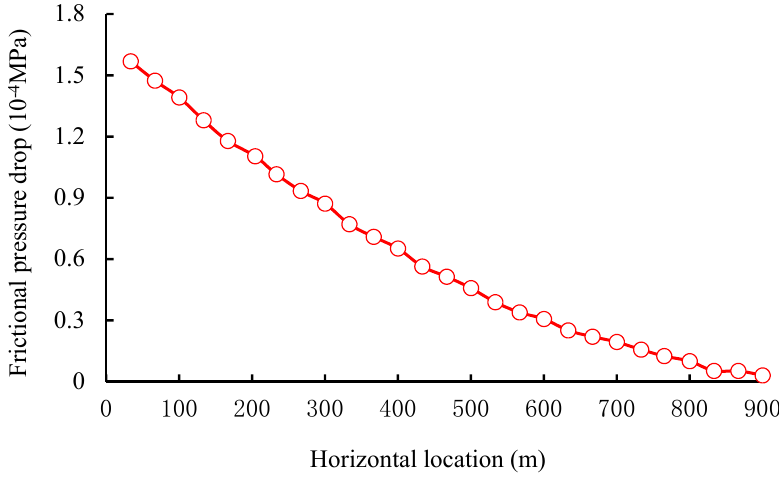
Figure 7. Evolution of frictional pressure drop across the horizontal wellbore.